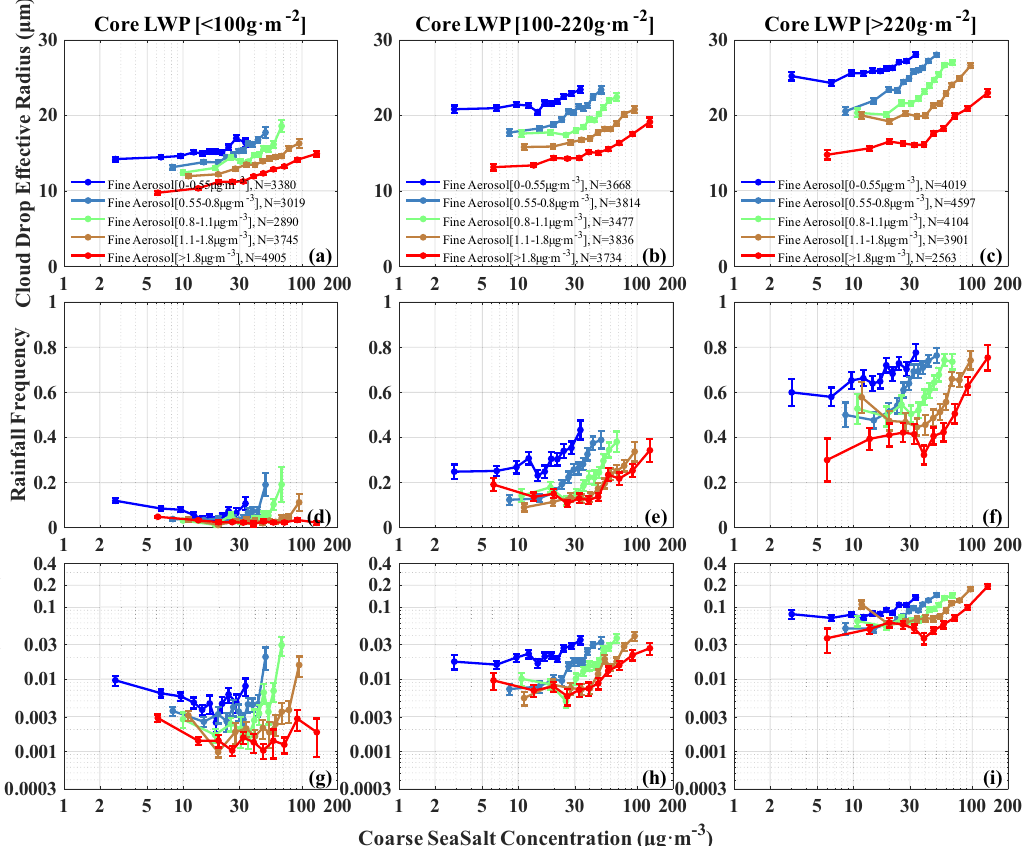
Fig. 5 Aerosol-driven cloud drop effective radius ( r e ) and rainfall variations of warm clouds for coarse sea spray aerosols (CSA) concentration under different constant intervals of fi ne aerosol concentration and cloud liquid water path (LWP). The three columns represent low, moderate, and high cloud liquid water path, respectively. Shown are r e ( a – c ), rainfall frequency ( d – f ), and g – i rainfall fl ux (including both rainfall and non-rainfall cases). The color lines connect the dots, which are the averaged r e , rainfall frequency and fl ux at eleven bins of CSA concentrations, including the 0 – 5%, 5 –